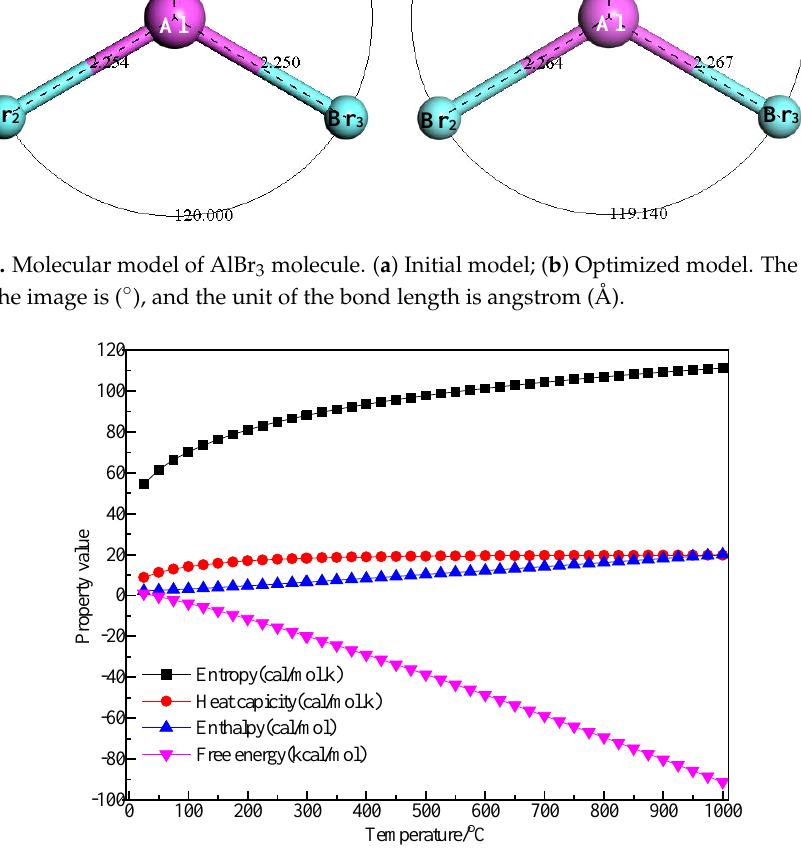
Figure 11. The relationship between the thermodynamic properties of AlBr 3 and temperature. Table 1. The total energy and the thermodynamic properties at 298.15 K of each component. Substance E ( 1 Har/at) H (kcal/mol) Table 2. The thermodynamic properties during Al reacting with C 2 H 5 Br to produce (C 2 H 5 ) 2 AlBr and C 2 H 5 AlBr 2.